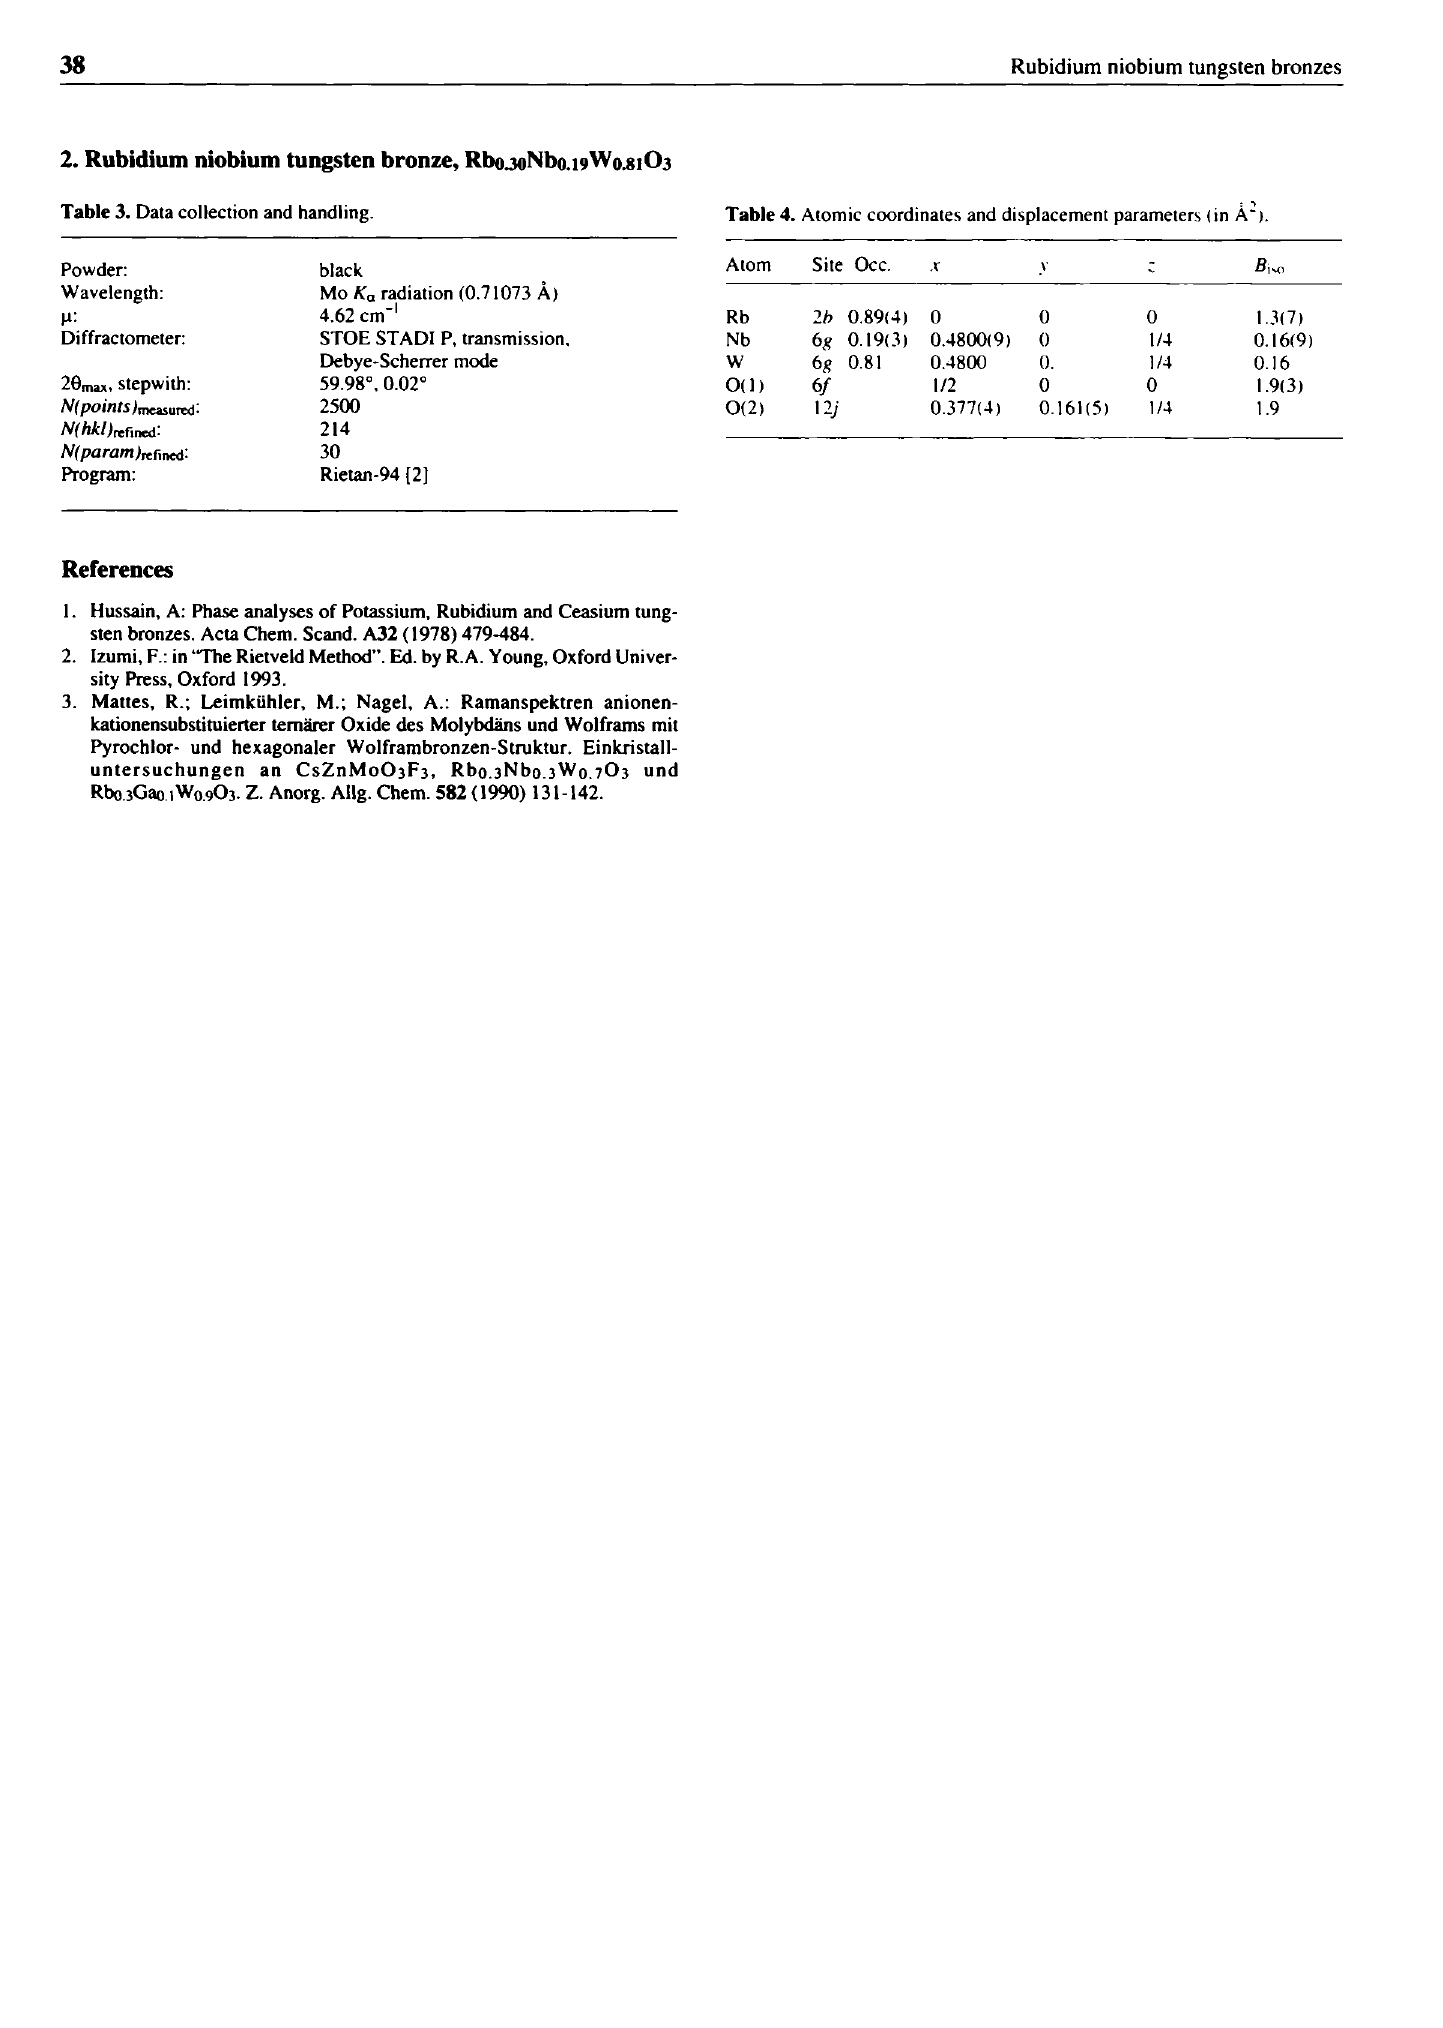
Table 3. Data collection and handling. Table 4. Atomic coordinates and displacement parameters (in